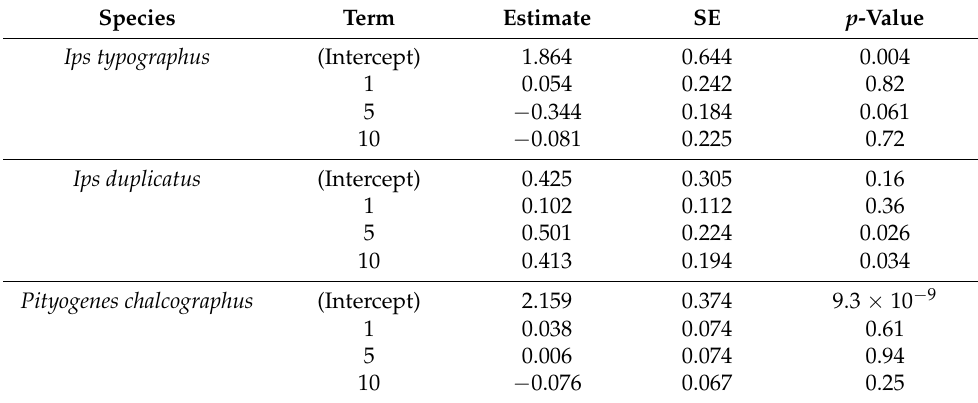
Table 3. Relationships between the number of maternal galleries and plot, type of trees (distance from lure tree), and height of position of strip on trap tree as indicated by the general linear model 1/(maternal gallery) ~ 1 + plot + type + height. The coefficient estimates are accompanied with the standard error of estimate (SE) and the p -values. Species